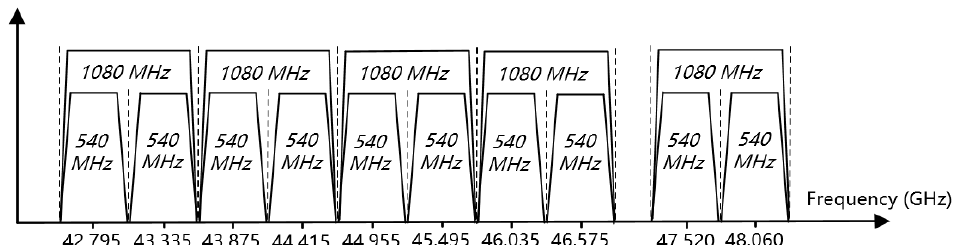
Figure 1. Channel allocation for IEEE802.11aj (45 GHz) standard.